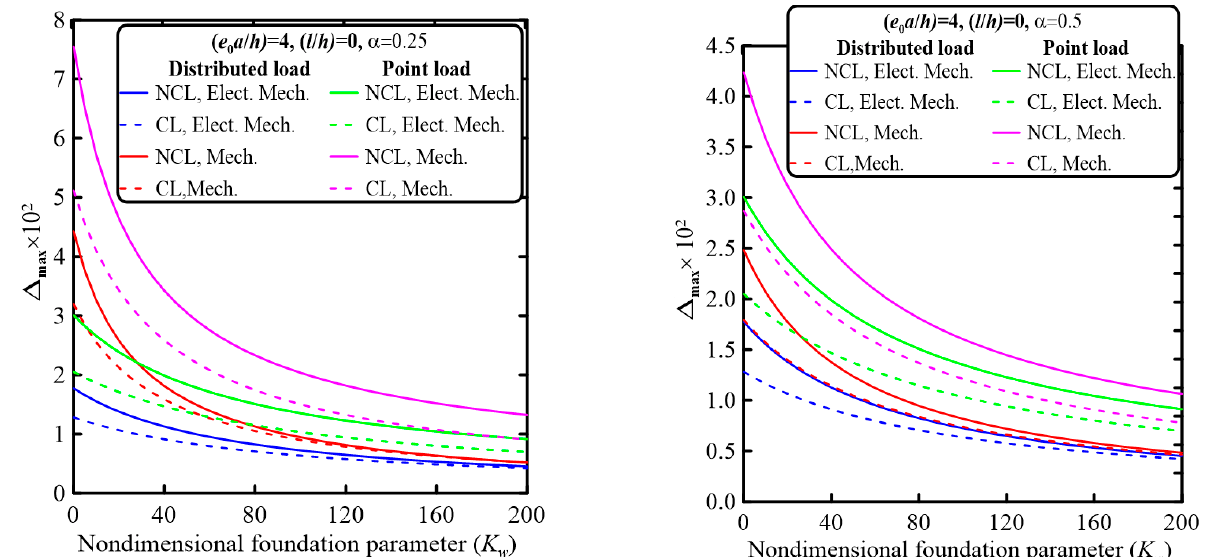
Figure 4. Variation in the maximum transverse deflection Δ max with the nondimensional elastic foundation parameter K w for nonclassical and classical electromechanical and mechanical behaviors under uniformly distributed and point loads at different values of perforation filling ratio, α = 0.25 and 0.5, at N = 4 and beam aspect ratio L / h = 20, e 311 = − 4.1 C/m 2 , μ 3111 = 5 × 10 − 8 C/m, a 33 = 7.124 × 10 − 9 C/m 2 K, and K p = 0.